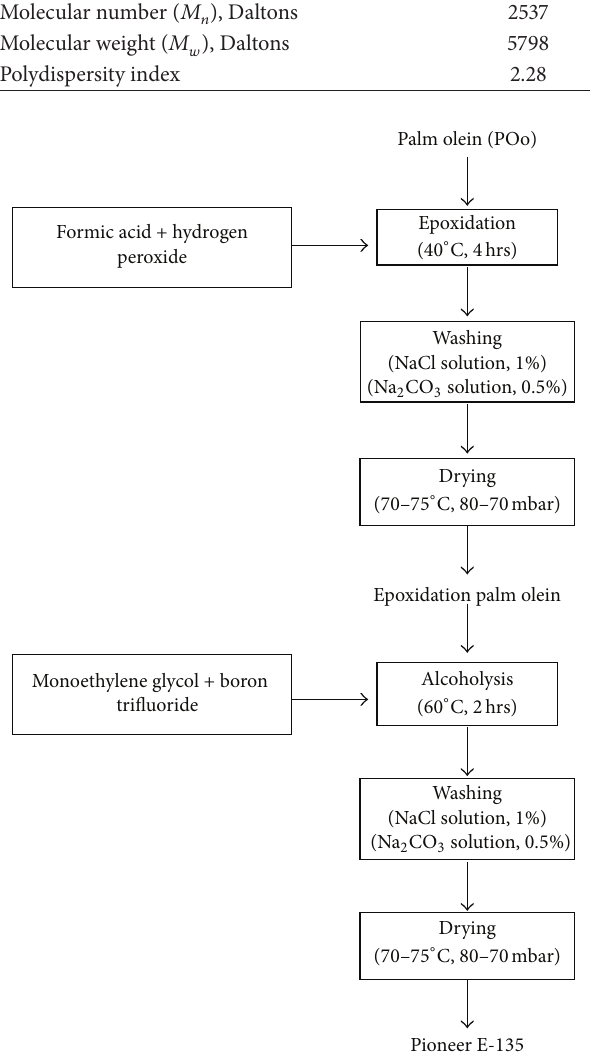
Figure 2: Flowchart of the production of Pioneer